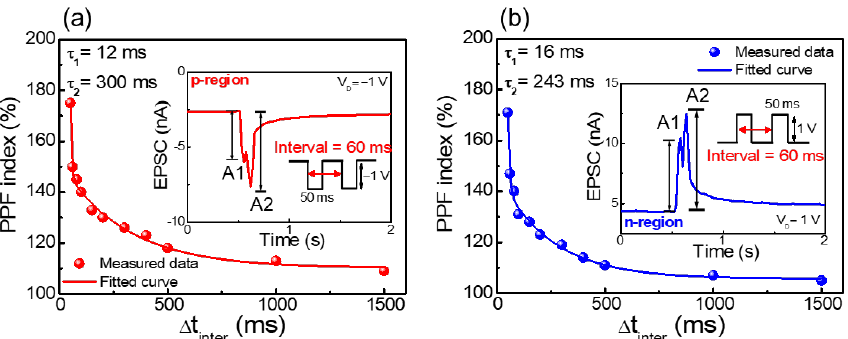
Figure 6. ( a ) Schematic of the EPSC measurement circuit of the ambipolar chitosan synaptic transistor. ( b ) EPSC retention characteristics due to pre-synapse spike in both regions. Resting EPSC variation for pre-synapse spike amplitude of the ( c ) p-region and ( d ) n-region.